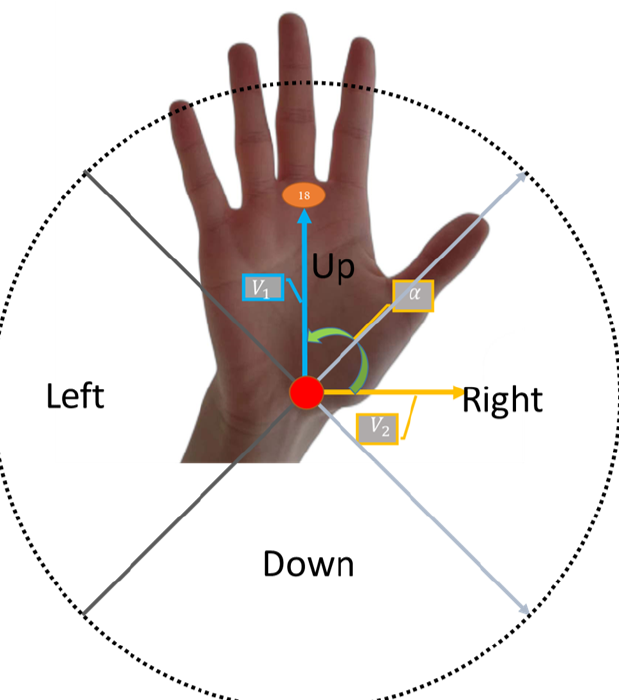
Figure 2. Determining the palm orientation. The contents marked with V 1 , V 2 , and α have the same meaning as in Figure 1.